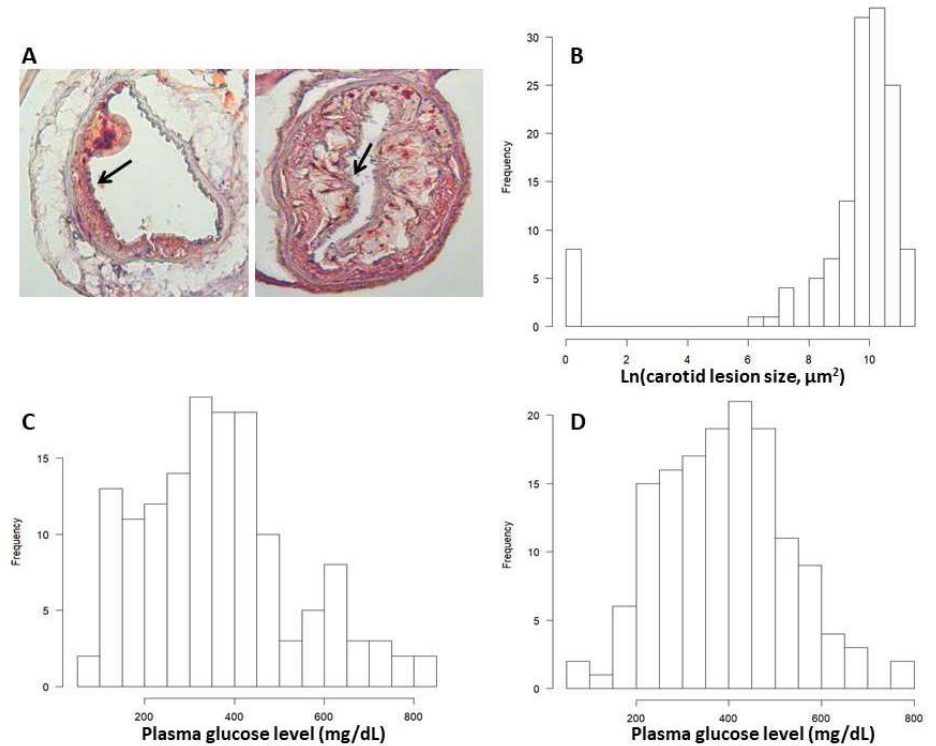
Figure 1. Representative images of carotid atherosclerosis ( A ) and trait value distributions of log- transformed carotid lesion sizes ( B ), fasting ( C ) and non-fasting plasma glucose levels ( D ) of F2 mice. Sections were stained with oil red O. Arrows point at atherosclerotic lesions. The bar graphs were created with a plot function of R/qtl.